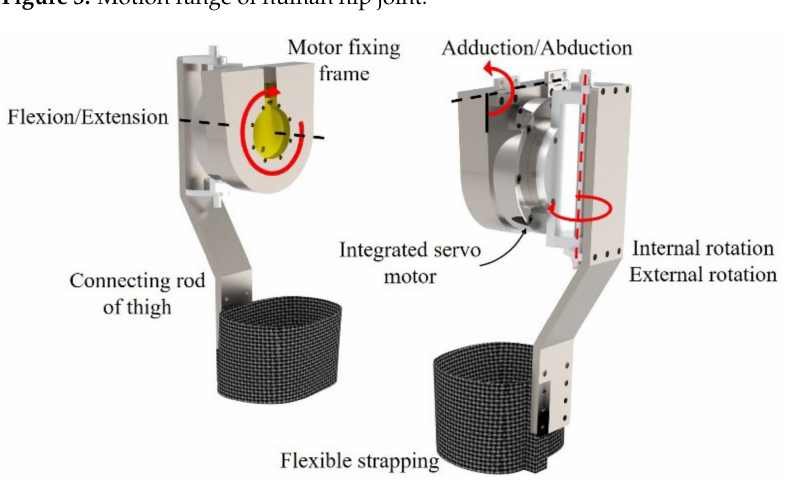
Figure 4. Hip exoskeleton structure.